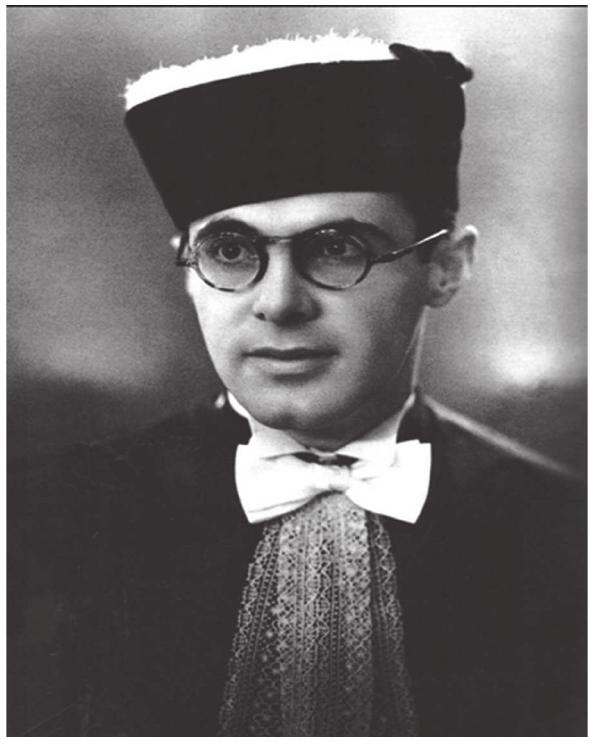
Fig. 4 – Graduação na Faculdade de Medicina da Universidade